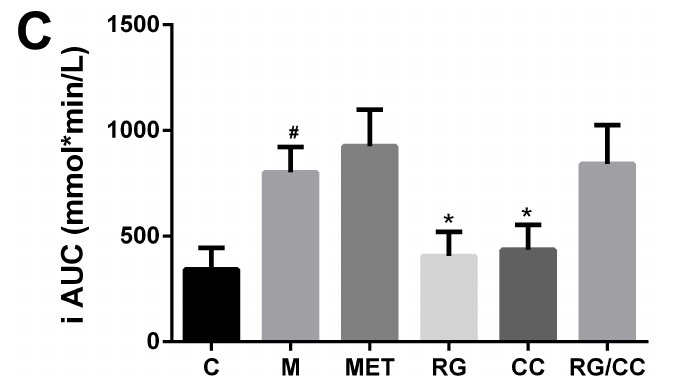
Figure 2. Results of a glucose tolerance test in diabetic KK-Ay mice performed at the end of 56 days of treatment. ( A ) blood glucose level after glucose loading; ( B ) AUC: area under the curve of OGTT; ( C ) iAUC: incremental area under the curve of OGTT. # p < 0.05, ## p < 0.01 and ### p < 0.001 meant significant difference of the measurement in the indicated group compared with the normal control group (C); * p < 0.05 and ** p < 0.01 meant significant difference of the measurement in the indicated group compared with the model control group (M).